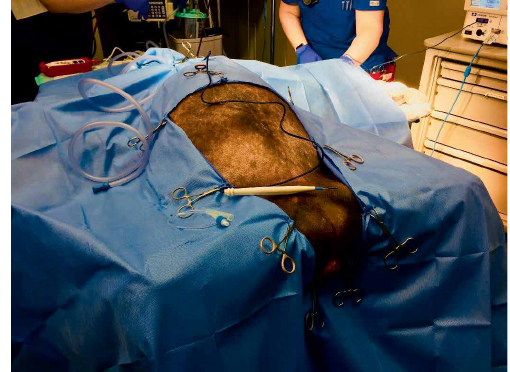
Figure 2: Draping of the patient.